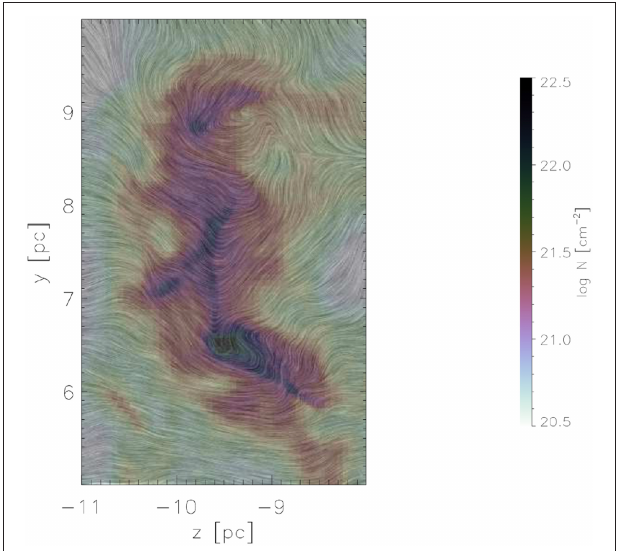
FIGURE 8 | Structure of the magnetic field within a self-gravitating filament (Gómez et al., 2018). The structure of the mass weighted magnetic field integrated along the line of sight is shown on top of the column density. The magnetic field, that is primarily perpendicular to the direction of the filament, is then further stretched by the collapsing motions along the filament, resulting in a “U”-shaped magnetic field line geometry.